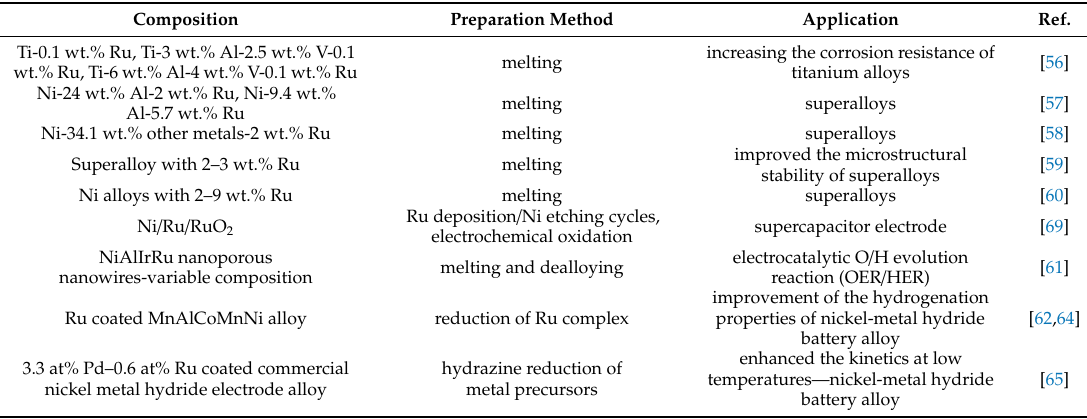
Table 2. Preparation and application of Ru / Ni